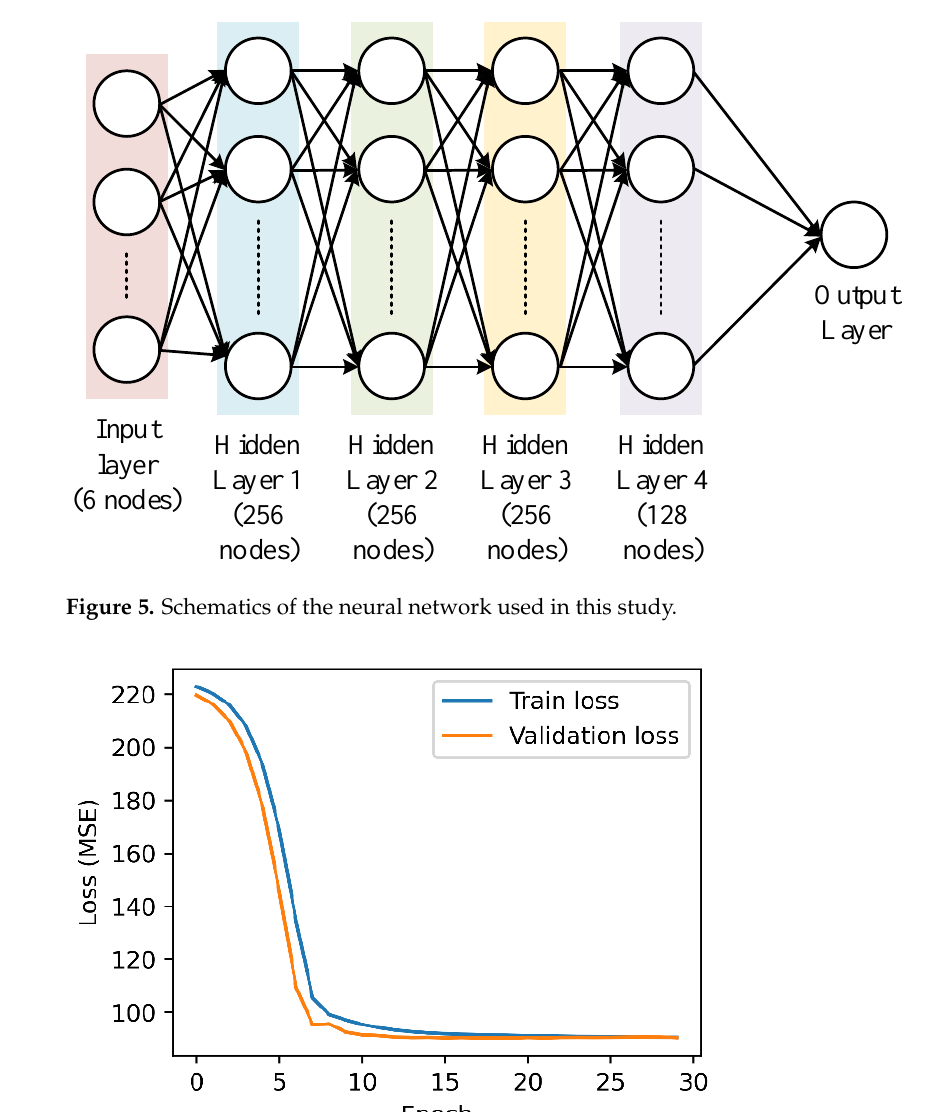
Figure 6. Neural network training and validation loss plots. Training was stopped at epoch 34 to prevent overfitting to the training data.